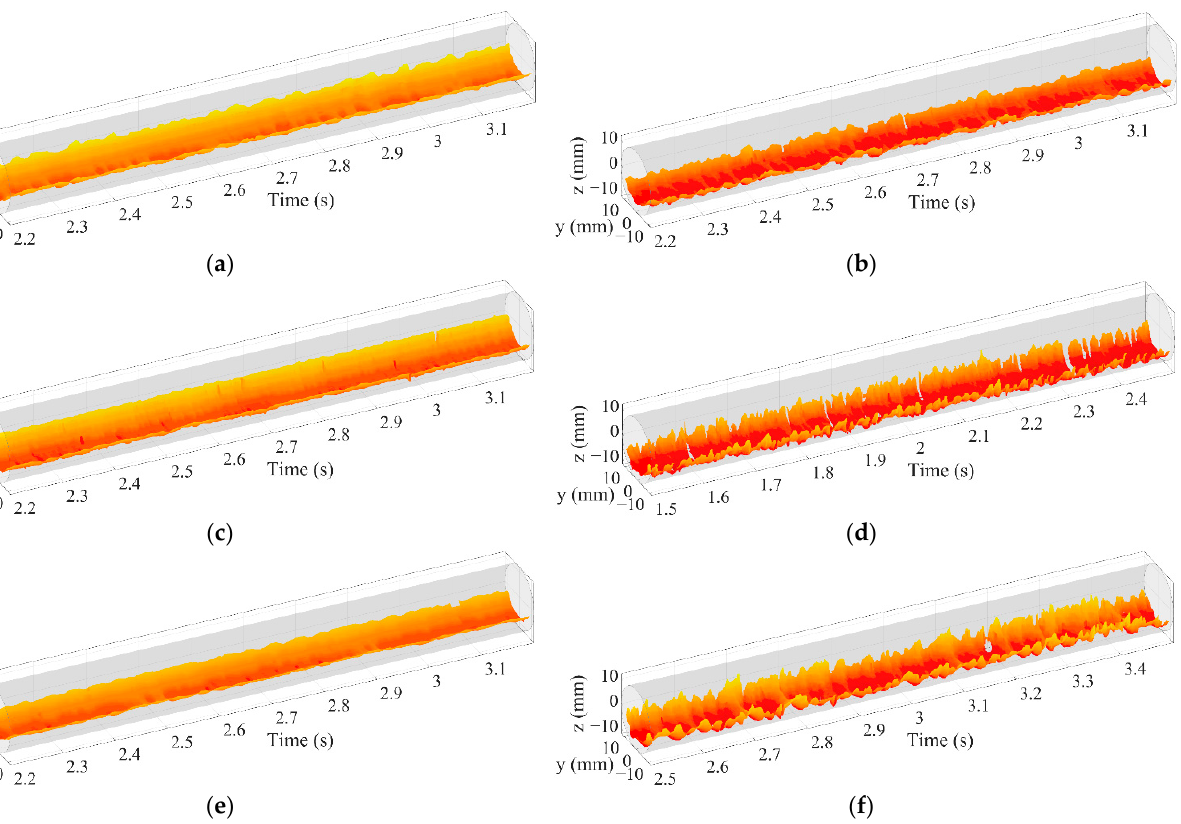
Figure 18. Evolution characteristics of oil–water interfacial configuration at different pipe inclinations ( U sw = 0.184 m/s): ( a ) U so = 0.368 m/s, ST&MI, 0°; ( b ) U so = 0.921 m/s, ST&MI, 0°; ( c ) U so = 0.368 m/s, ST&MI, +5°; ( d ) U so = 0.921 m/s, D W/O&D O/W, +5°; ( e ) U so = 0.368 m/s, ST&MI, +10°; ( f ) U so = 0.921 m/s, D W/O&D O/W, +10°.